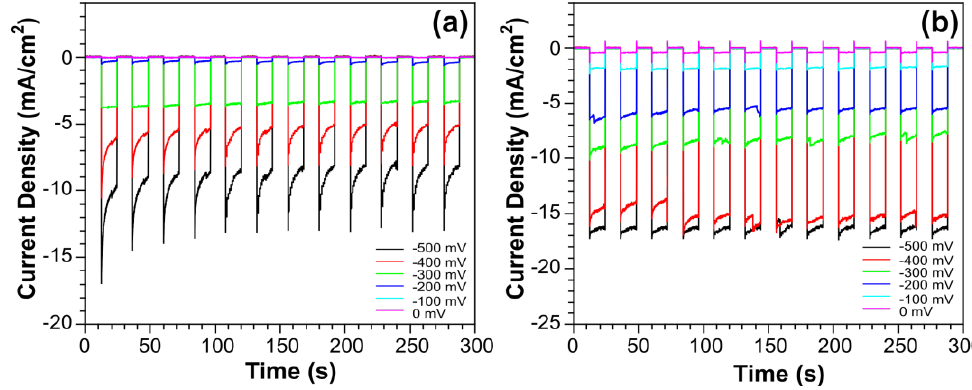
Figure 3. Photocurrent measurements showing current density as a function of time for ( a ) bare SiNWs and ( b ) SiNWs + {Ni 4 O 4 } clusters.